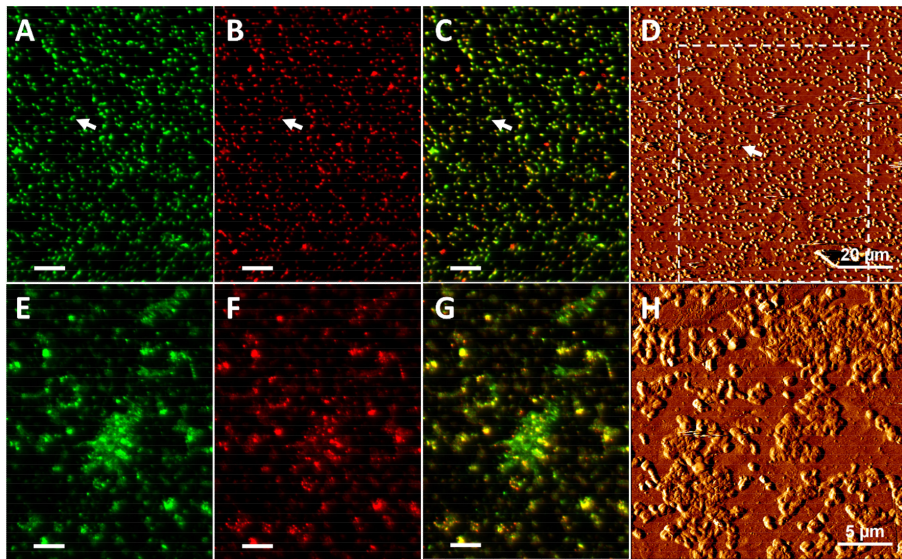
Figure 4. Surface colonization and partial biofilm formation by Sb. thermosulfidooxidans 6 on a pyrite coupon after 3 days ( A – D ) and 7 days ( E – H ) of incubation at 30 ◦ C and shaking at 130 rpm in the dark. AFM images ( D , H ), EFM images ( A – C , E – G ). EFM images: ( A , E ) biofilm cells stained by Syto ® 9 (Green). ( B , F ), biofilm cells stained by TRITC-Con A (Red). ( C , G ) combination of Syto ® 9 and TRITC-Con A. The framed area in ( D ) corresponds to the same area in ( A – C ) observed by EFM. Bars in ( A – C ,E–G) represent 10 µ m. Solid arrows in ( A – D ) point at the same